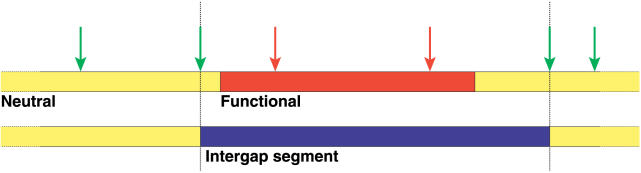
Model for the Relation between Ungapped and Functional SegmentsIndel events (modeled as point events, and represented by arrows) affecting functional DNA (red) are purified from the population and are not observed in extant species. The remaining indels (green arrows) delineate ungapped segments. Those subtending a segment of functional DNA (dark blue) are longer than the functional element itself, and the amount of neutral sites included in these long ungapped segments is on average twice the expected distance between indels on neutrally evolving DNA (see Materials and Methods).